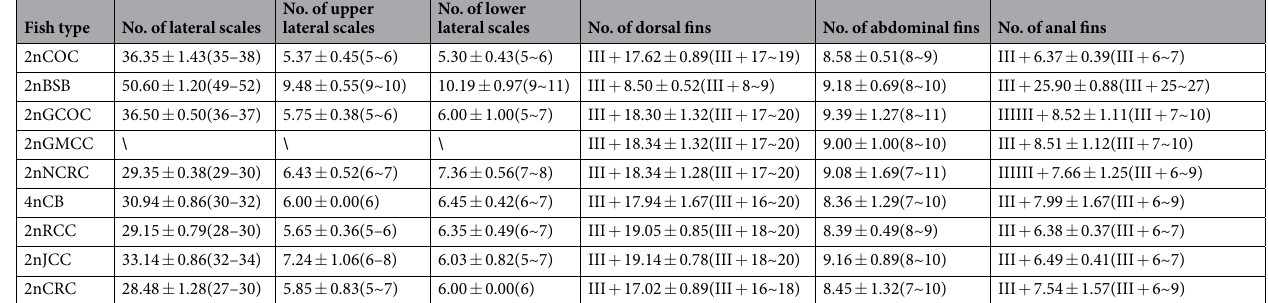
Table 3. Comparison of the countable traits between the different offspring and their parents. Uppercase Roman numerals indicate the number of spines, and Arabic numerals reflect the number of soft fins. The numbers before and after the symbol “ ± ” present the mean and standard deviation of the numbers of fins, respectively, and “~” indicates the range of the measured number of fins.